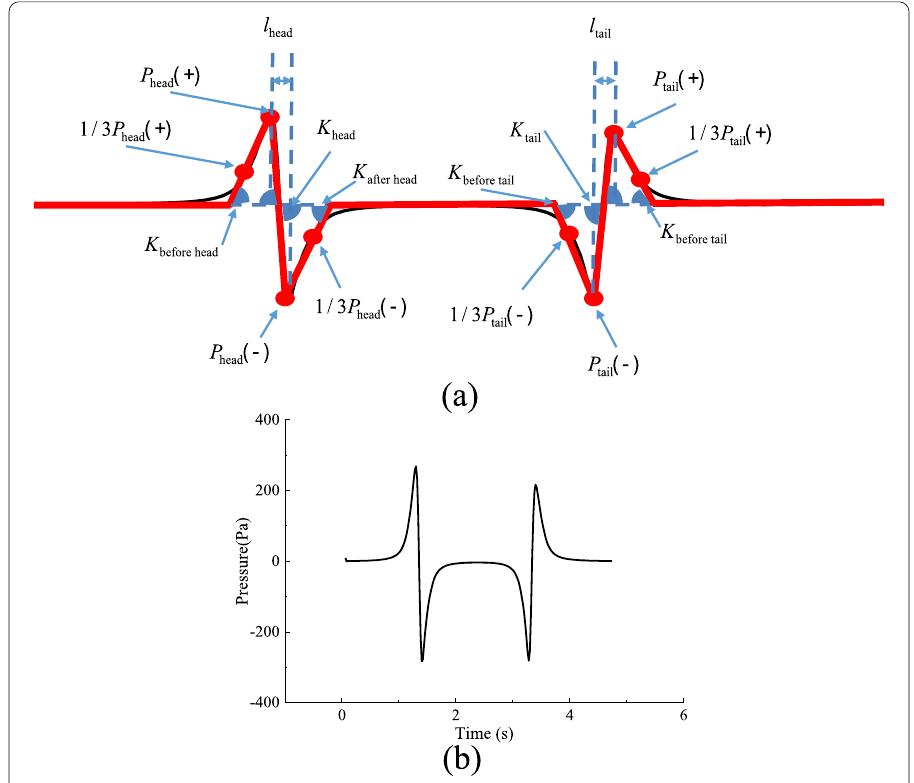
Fig. 10 Wind pressure curve model of bottom plate: a simplified diagram of a-di-1 wind pressure curve; b wind pressure time history curve of bottom